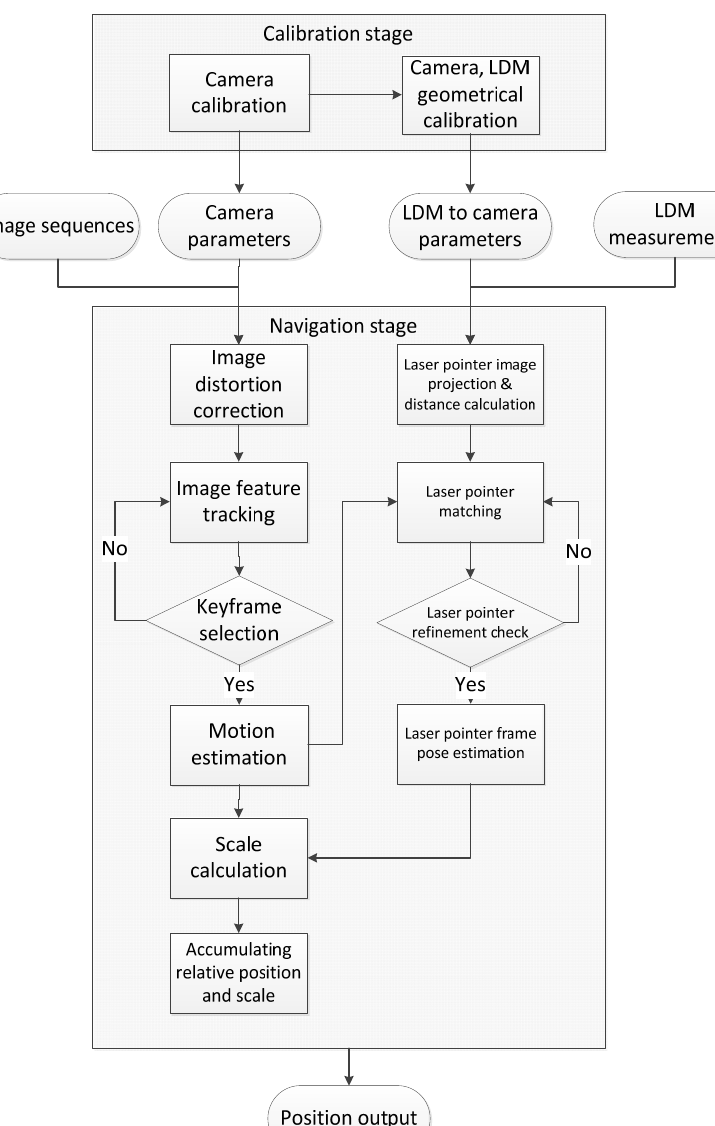
Figure 4. Flowchart of the enhanced monocular VO system